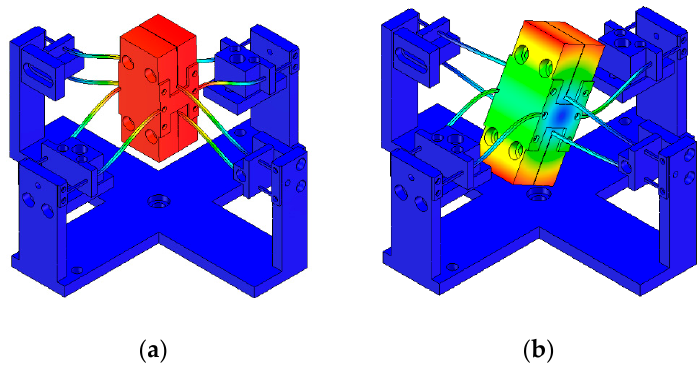
Figure 12. Mode shapes of TMD1. ( a ) The 1st mode; ( b ) the 2nd mode.